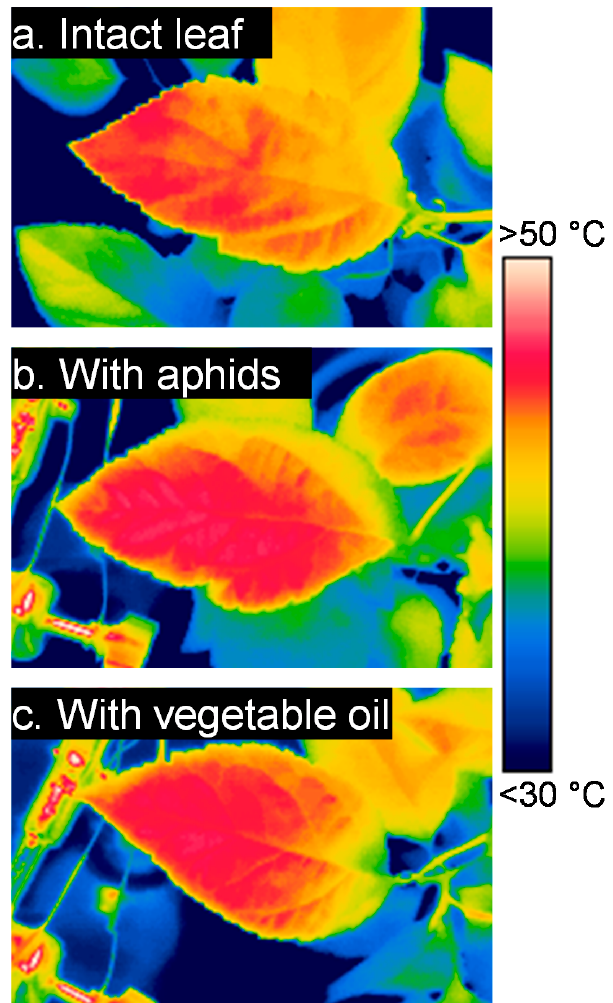
Figure 1. Example of three infrared images showing an intact apple leaf surface ( a ), a leaf with aphids on the adaxial (i.e., lower) apple leaf surface ( b ) and a leaf with the adaxial surface covered with vegetable oil to inhibit evapotranspiration ( c ). These images were taken at air temperature 29 °C and irradiance level 230 W · m − 2 . The same color scale was set to the three images.